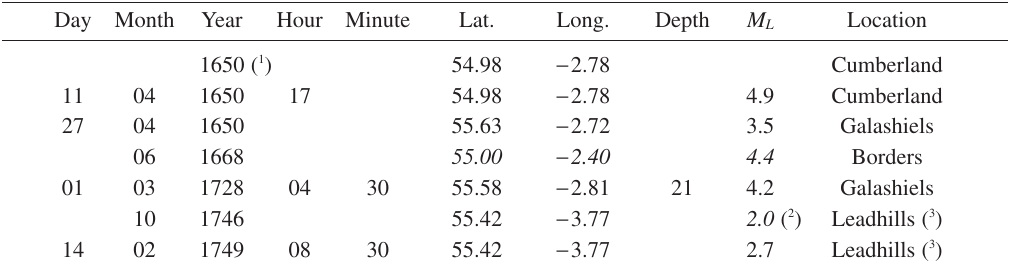
Table I. Earthquakes in the study area before 1750. Parameters in italics are very approximate